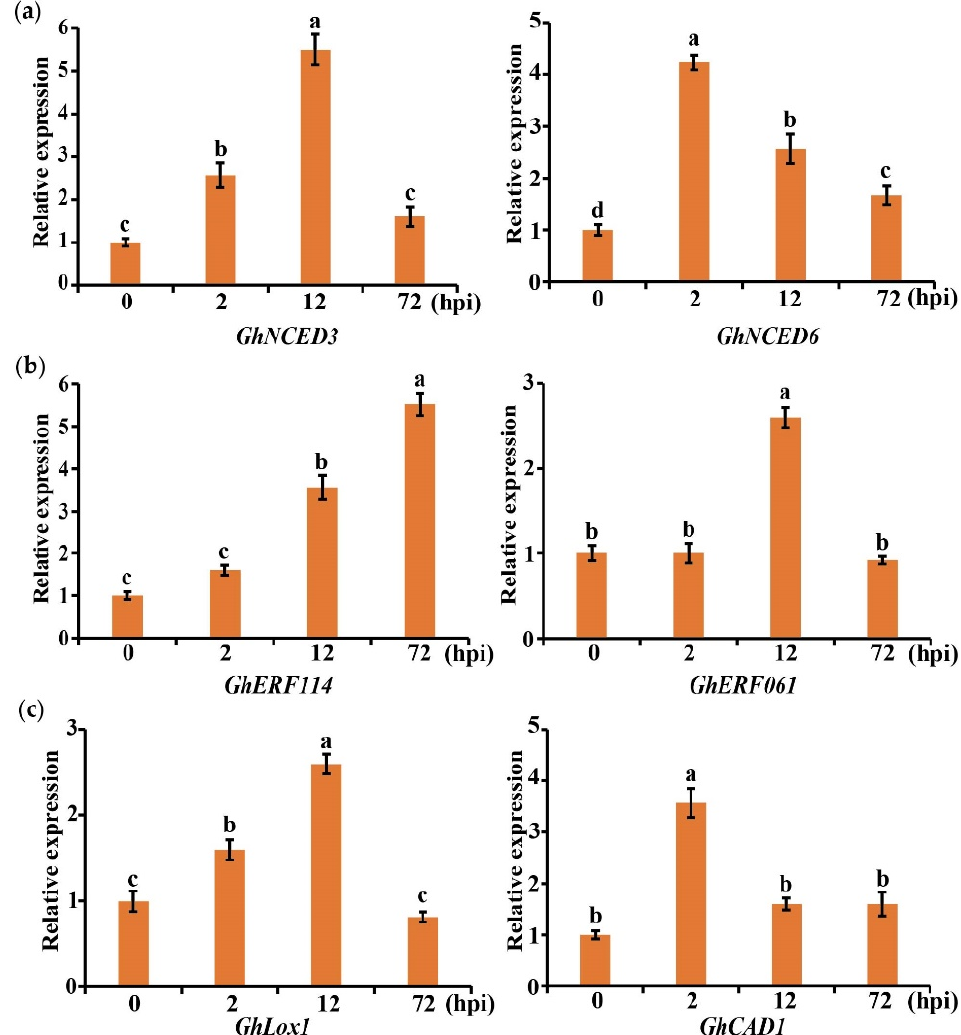
Figure 8. Marker genes were used to detect whether ABA, ethylene, and secondary metabolite-related pathways were involved in the response of cotton to V. dahliae . ( a ) Marker genes in ABA-related pathways. ( b ) Marker genes in ethylene-related pathways. ( c ) Marker genes in secondary metabolite- related pathways. Error bars represent the standard deviations and different letters indicate significant differences at p <